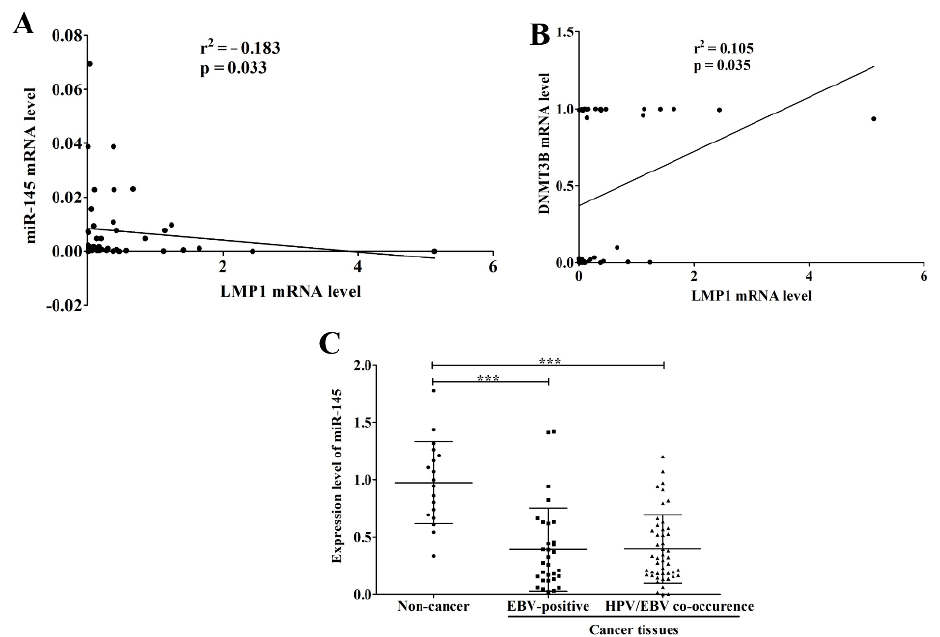
Figure 5. EBV infection is associated with the down-regulation of miR-145. The correlation of LMP1 mRNA level with miR-145 ( A ) and DNMT3B ( B ) mRNA levels was analyzed by Pearson correlation. Expression data of miR-145 in normal and HNSCC tissues, that were obtained from microarray data (GSE82064), were analyzed and plotted according to the infection of EBV and/or HPV ( C ). ***: p < 0.0001.